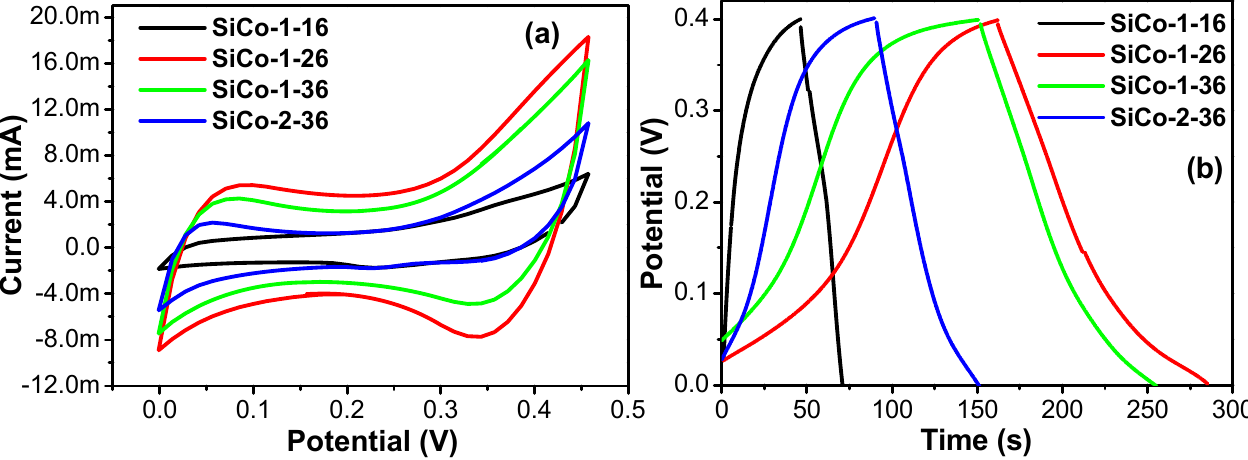
Figure 7. Comparative ( a ) CV curves of the SiCo-1-16, SiCo-1-26, SiCo-1-36, and SiCo-2-36 LDH electrodes at fix scan rate of 5 mV/s; and ( b ) CD curves of SiCo-1-16, SiCo-1-26, SiCo-1-36, and SiCo-2-36 LDH electrodes at fixed current density of 2 A g − 1 . Figure 7a represents the comparative CV graphs of the SiCo ‐ 1 ‐ 16, SiCo ‐ 1 ‐ 26, Si ‐ Co ‐ 1 ‐ 36 and Si/Co ‐ 2 ‐ 36 LDH electrodes at a fixed scan rate, which reveals the impact of